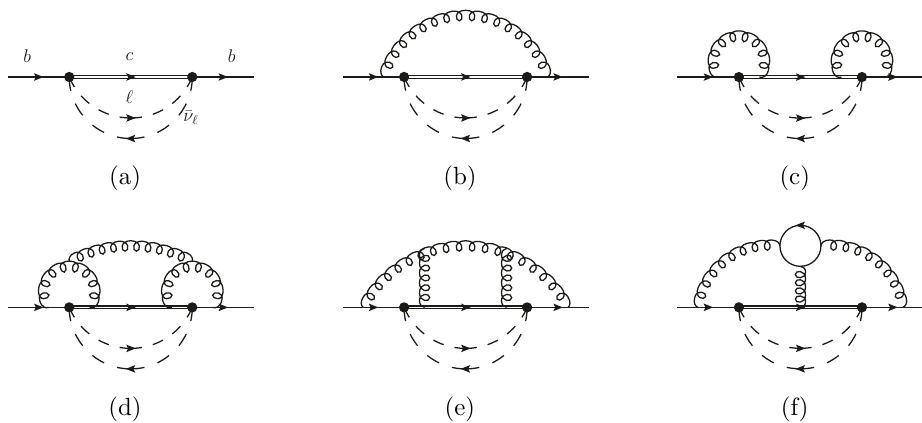
Figure 1 . Sample Feynman diagrams which contribute to the forward scattering amplitude of a bottom quark at LO (a), NLO (b), NNLO (c) and N 3 LO (d)–(f). Straight, curly and dashed lines represent quarks, gluons and leptons, respectively. The weak interaction mediated by the W boson is shown as a black